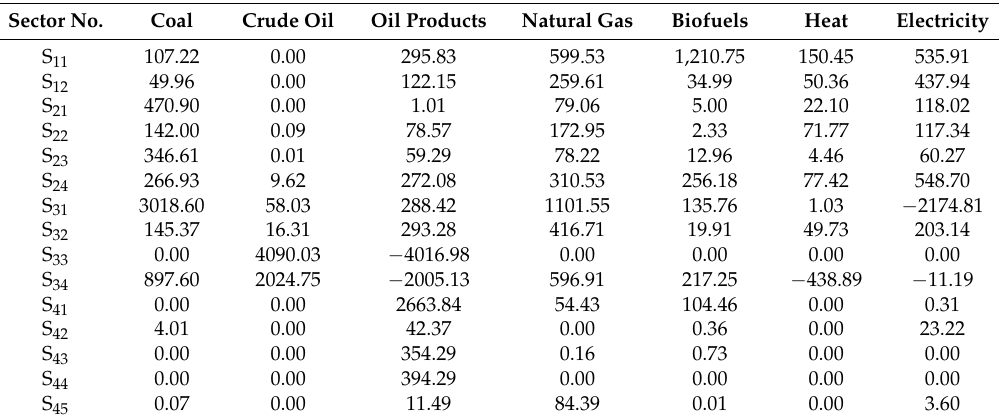
Table 2. Energy consumption in various sectors ( E ij